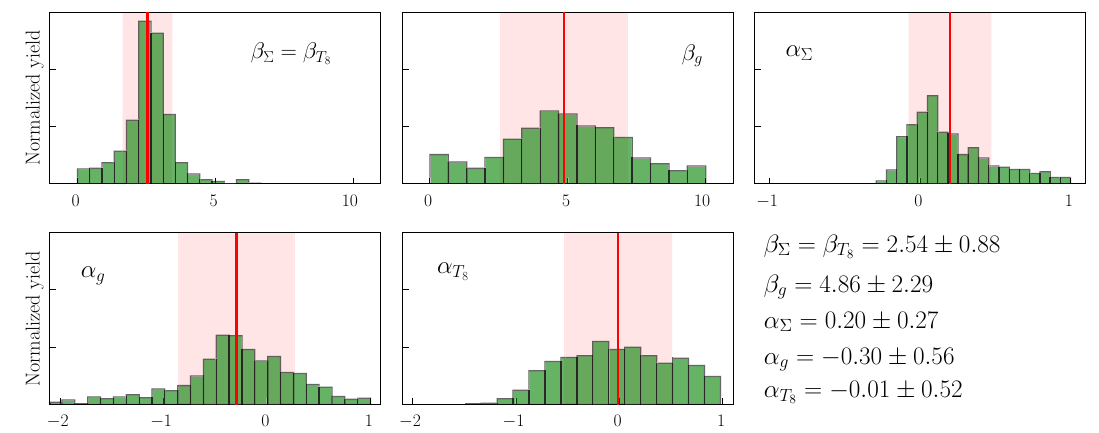
Fig. 5 The probability distribution of the fitted preprocessing exponents computed with the N rep = 1000 replicas of the nNNPDF1.0 NLO set. The vertical red line indicates the mean value and the transparent red band the 1 − σ range corresponding to each exponent